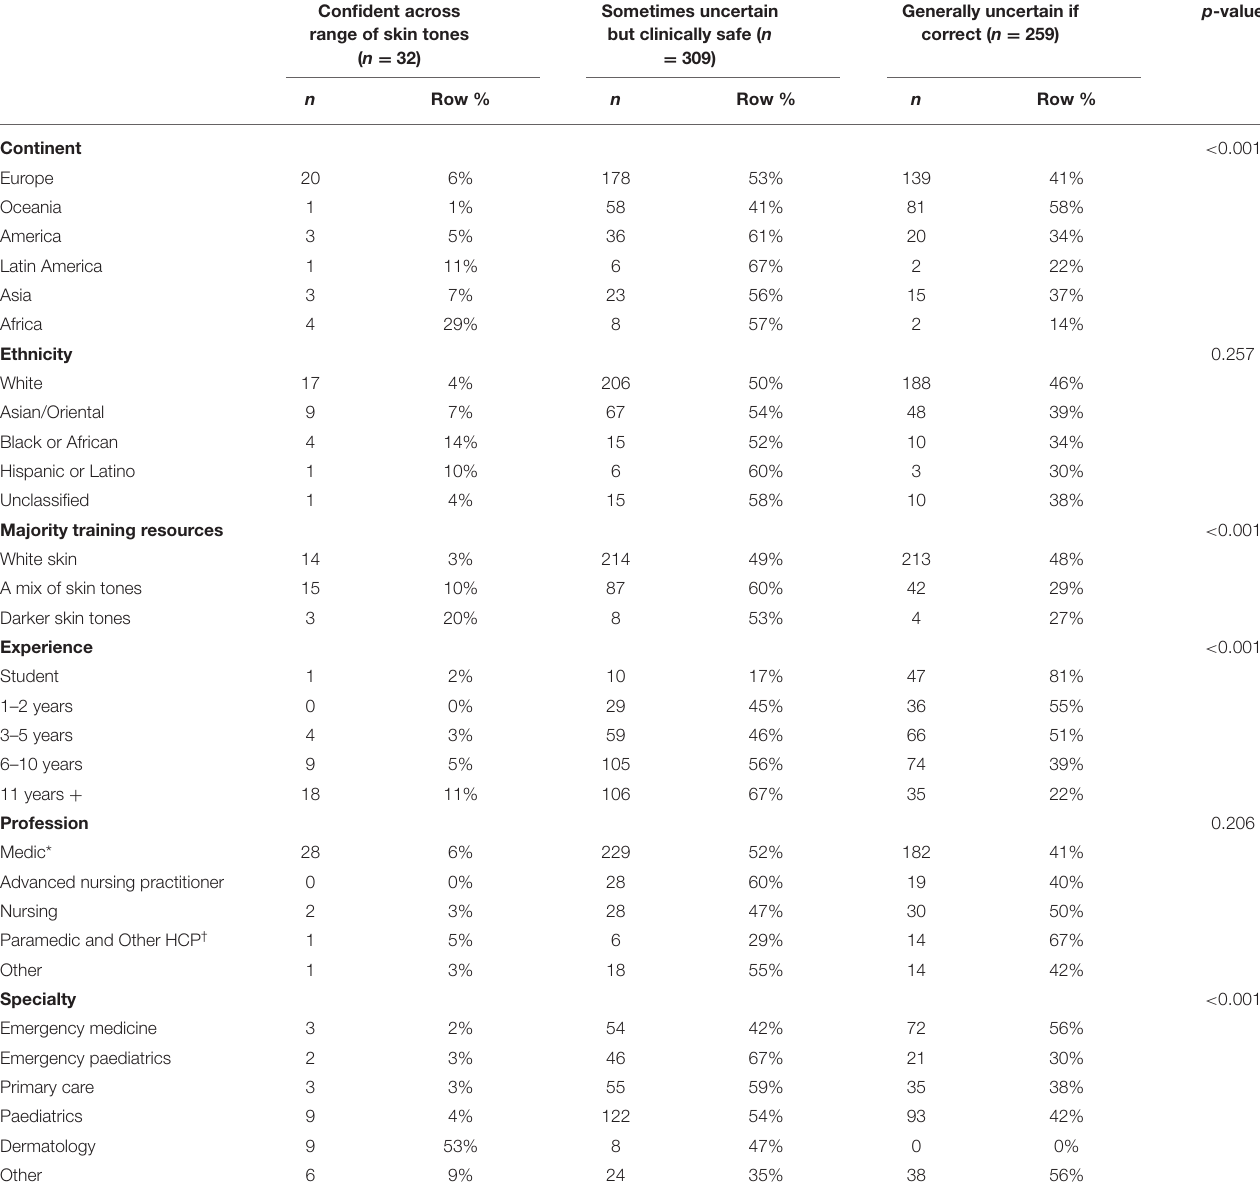
TABLE 2 | Self-reported confidence in diagnosis.